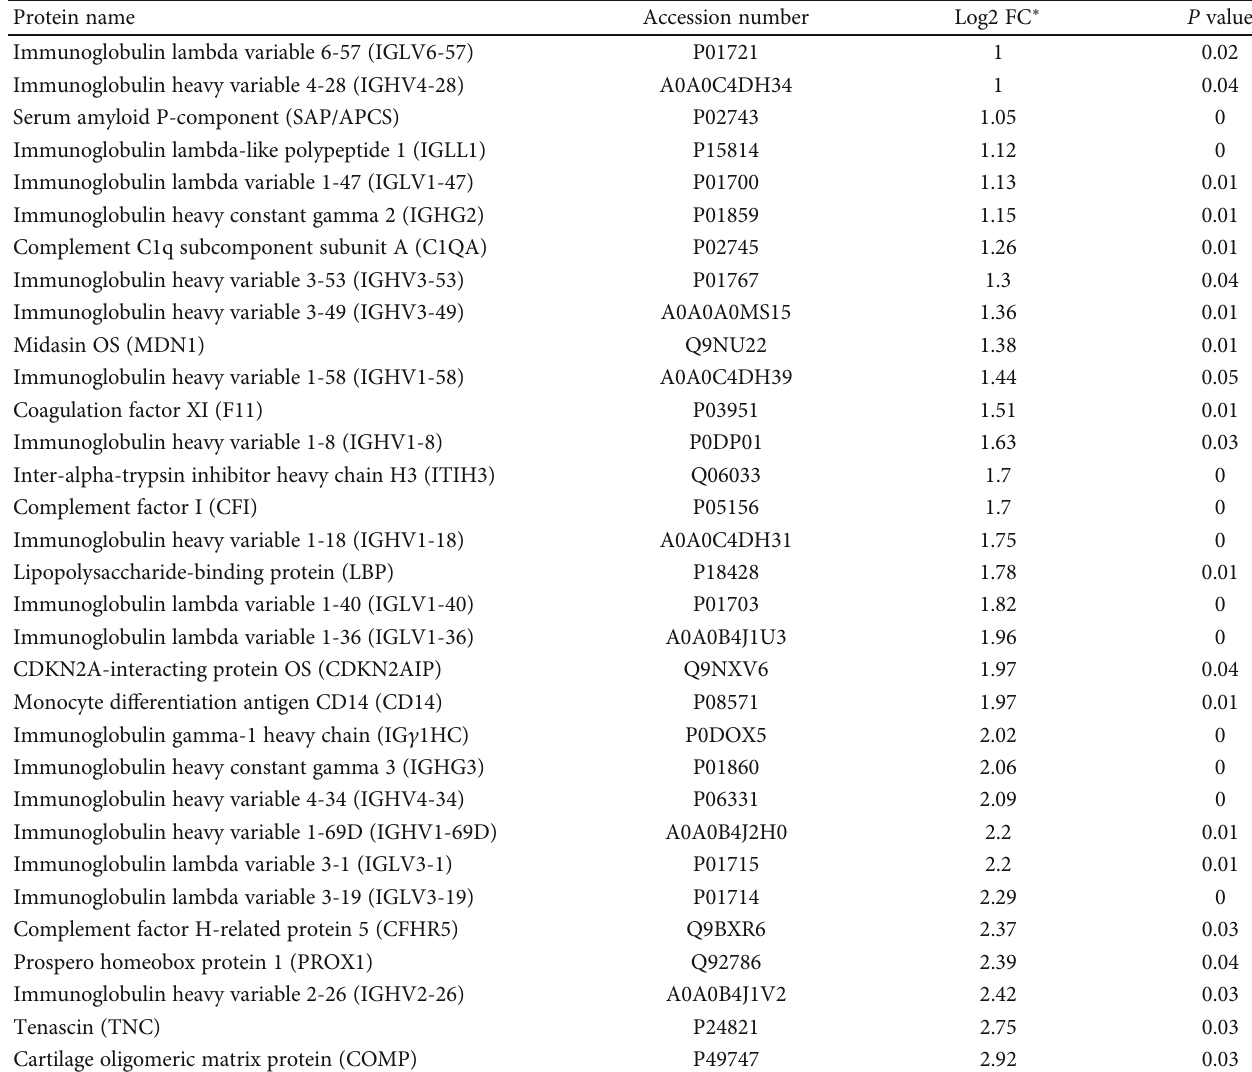
Table 2: The di ff erentially overexpressed exosomal proteins in rheumatoid arthritis.